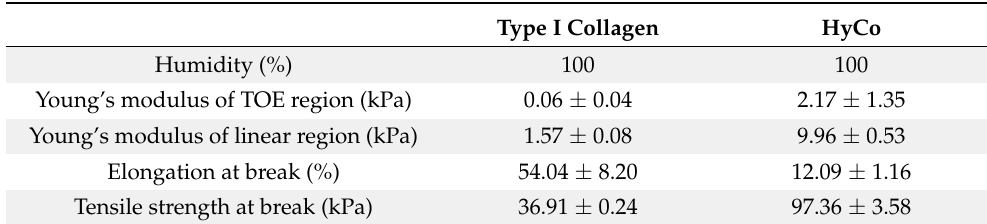
Table 1. Young’s modulus, stress at break, and elongation at break of commercial collagen scaffold and